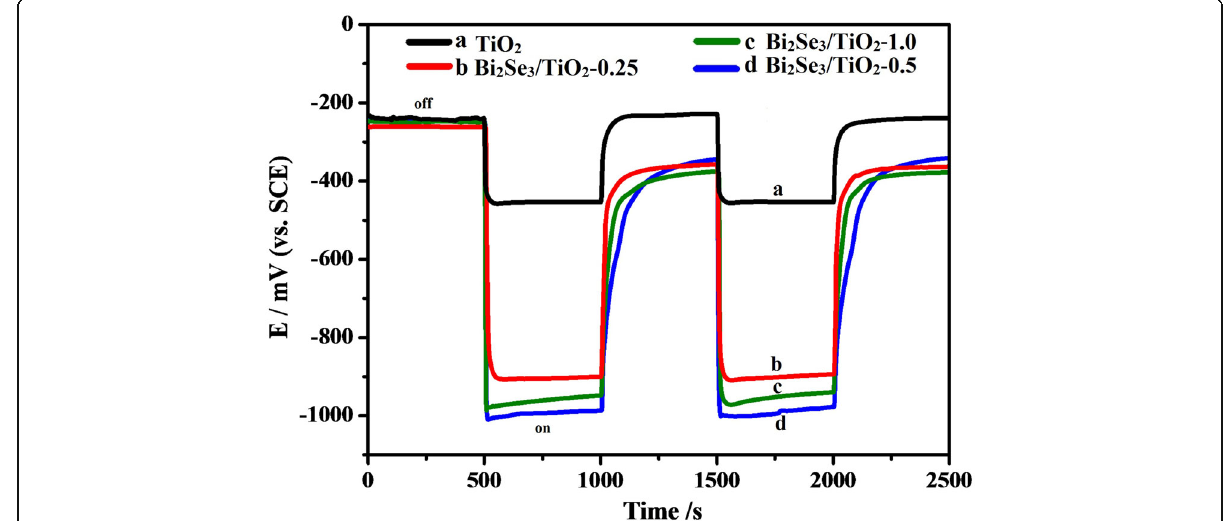
Fig. 5 OCP for 304ss coupled with pure TiO 2 and Bi 2 Se 3 /TiO 2 nanocomposites in a 0.5 mol NaCl solution